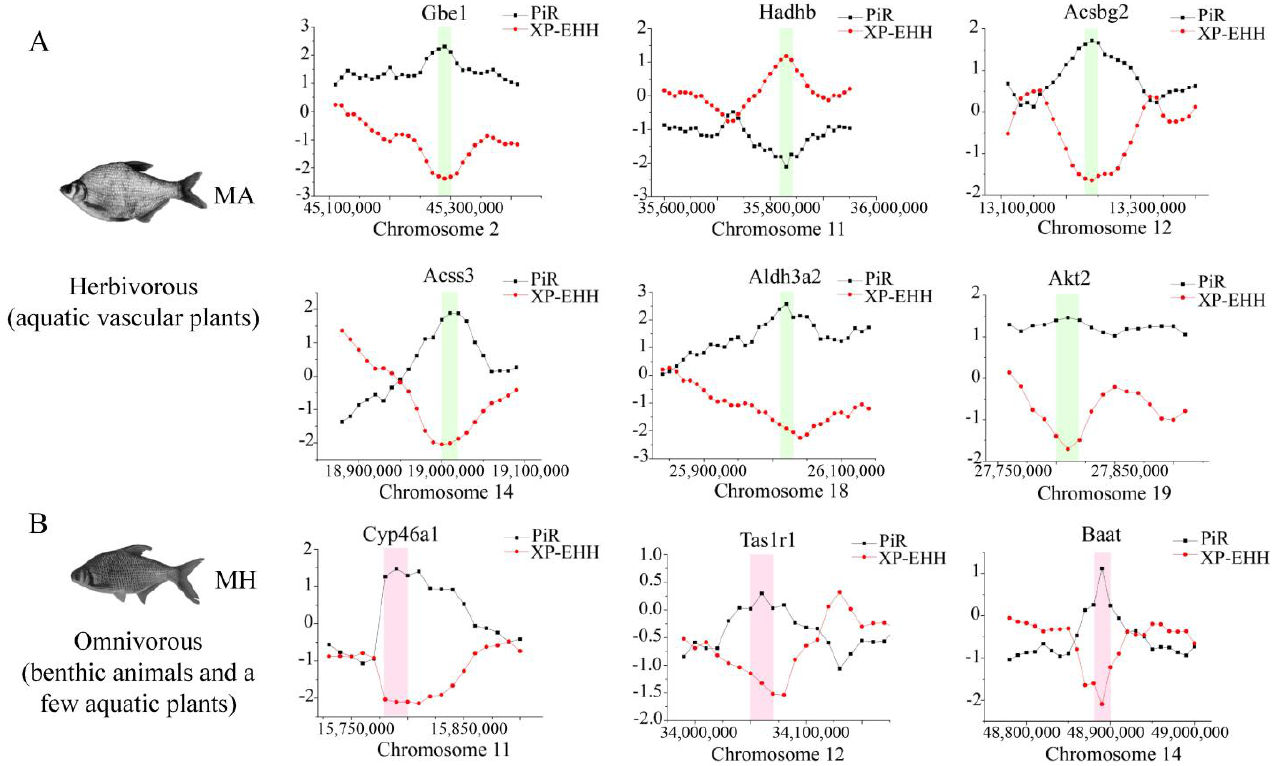
Figure 5. Genome-wide inference of selection sweeps on chromosomes during the diet adaptation of M. amblycephala ( A ) and M. hoffmanni ( B ). MA and MH refer to M. amblycephala and M. hoffmanni . Gbe1 , Akt2 , and Aldh3a2 were identified from the comparison between M. amblycephala and M. skolkovii , Acss3 , and Acsbg2 from the comparison between M. amblycephala and M. pellegrini, Hadhb from the comparison between M. amblycephala and M. hoffmanni, and Cyp46a1 , Tas1r1 , and Baat from the comparison between M. hoffmanni and M. amblycephala . The black curve indicates the nucleotide polymorphism ratio (PiR) analysis, and red curve indicates extended haplotype homozygosity between populations (XP-EHH) analysis. The green and pink boxes represent the position of the selected genes on the chromosomes.